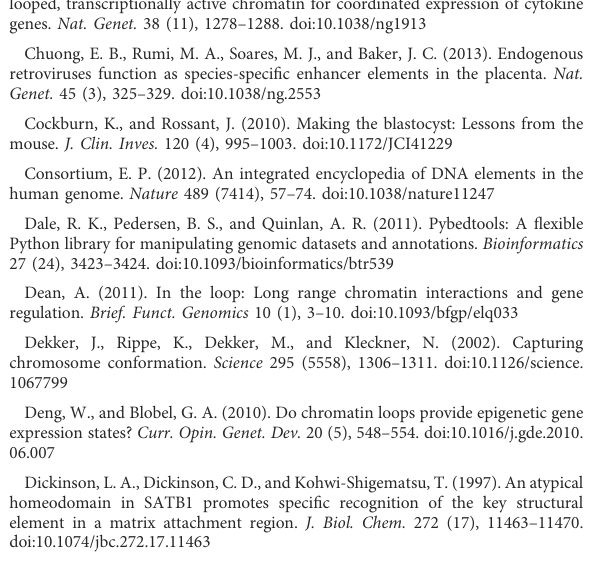
SUPPLEMENTARY FIGURE S1 Induction of Satb1 expression following reprogramming of mouse or human ES cells. Expression of Satb1 was induced when mES cells were reprogrammed towards trophoblast lineage following the overexpression of CDX2 (A) or GATA3 (D) (Ralston et al., 2010). Increased expression of Stab1 in the reprogrammed mES cells was associated with the upregulation of TS markers including Gata3, Elf5, Eomes, and Ascl2 (A – F) . BAP (BMP4, A83-01, and PD173074)-induction also induced reprogramming of human ES (hES) cells towards thetrophoblast lineage (Amita et al., 2013). Such reprogramming of human ES cells also upregulated SATB1 expression, along with increased expression of CDX2 and ELF5 (G – I) . RT-qPCR data are expressed as mean ± S.D. * p < 0.05 ( n =3). Cont, Control. SUPPLEMENTARY FIGURE S2 Satb1 transcript variants and control experiments for ChIP assays. (A) Schematicdiagramshowingthereference5 ’ sequencesoffourdifferent transcript variants of mouse Satb1. (B) The accession numbers, noncoding variant speci fi c fi rst exons, common second exons, coding sequences (CDS), and the transcription start sites on mouse chromosome 17 are presented in a tabulated form. Mouse positive and negative control primer sets were used for validating the ChIP assays (Supplementary Figure S2). ChIP-qPCR data are expressed as mean ± S.D. * p < 0.05 ( n =3). NC, Negative Control Primer Set; PC, Positive Control Primer